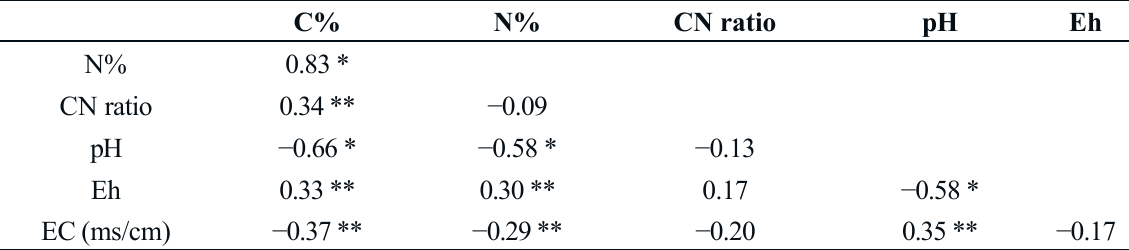
Table 5. Correlation matrix of surface soil properties along the transect ( n = 74).